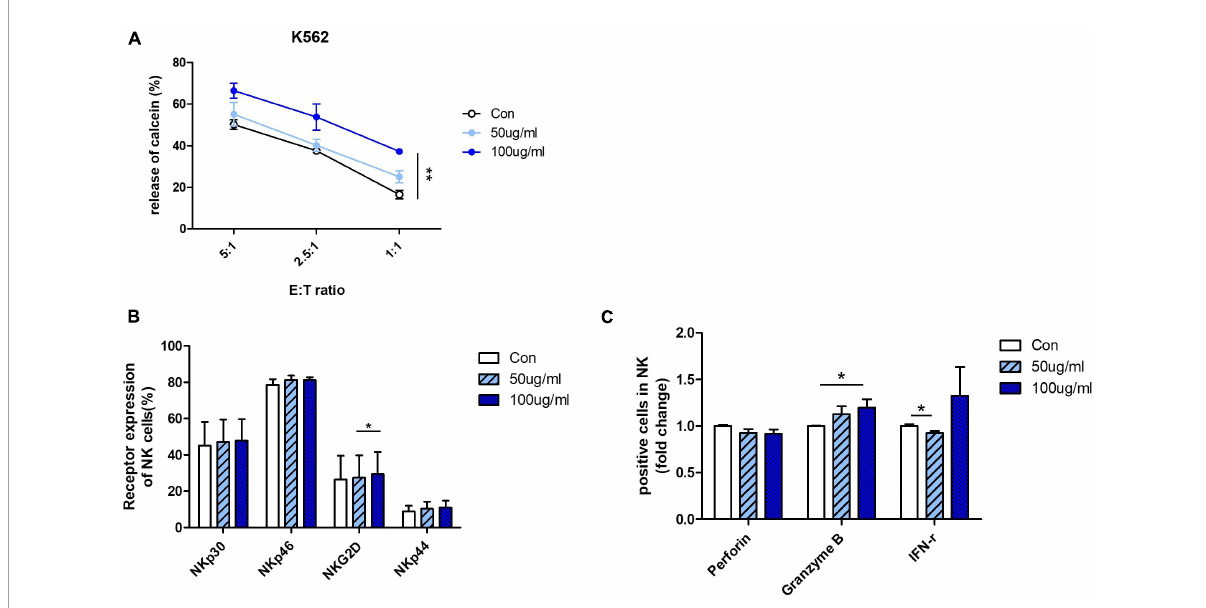
FIGURE3 Aurantii Fructus Immaturus (AFI) enhances activity of primary NK cells from cord blood. (A) Matured primary NK cells were cultured in either the absence (empty) or presence of 50 µ g/ml (sky blue) or 100 µ g/ml (blue) of AFI for 24 h and cytotoxicity against K562 cells was examined. (B) Expressions of NK activating receptors analyzed by flow cytometry. Graphs represent mean value of expression percentage for three independent experiments. (C) Expressions of granules in NK cells were analyzed by intracellular staining and flow cytometry. Graphs represent fold change values of granule positive cells compared to control. Bars represent the mean ± SEM of three independent experiments * p < 0.05 and ** p <